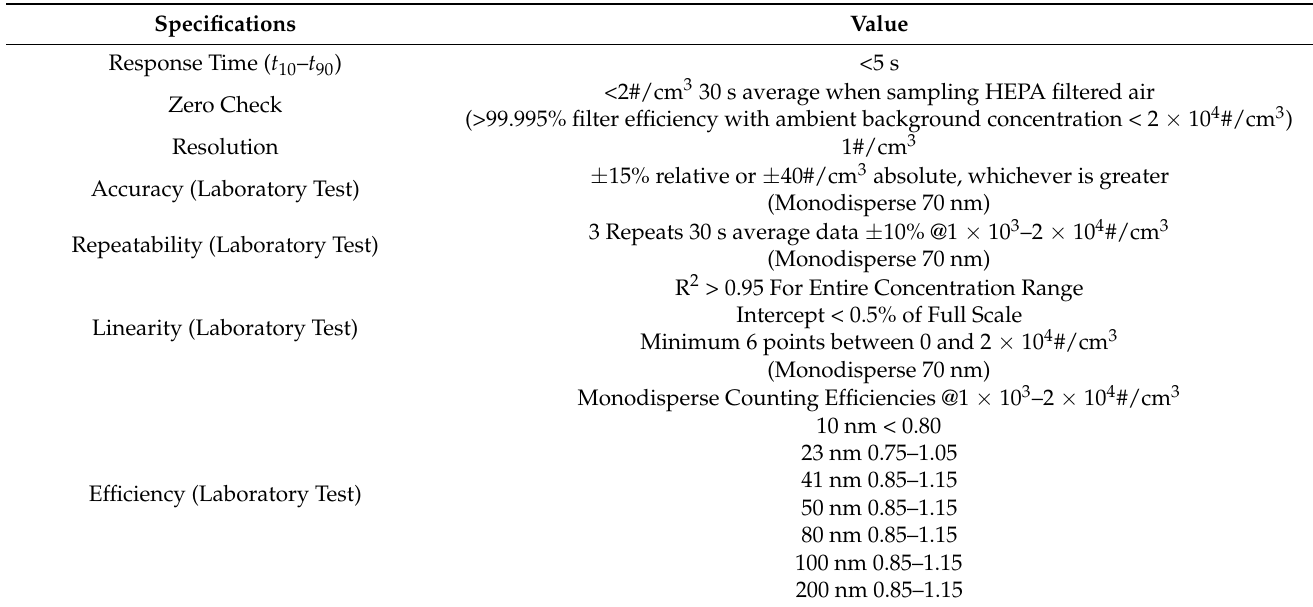
Table 1. Specifications of CPC